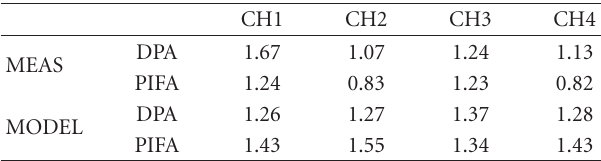
Table 3: The coherent bandwidth (in MHz) of each subchannel in all